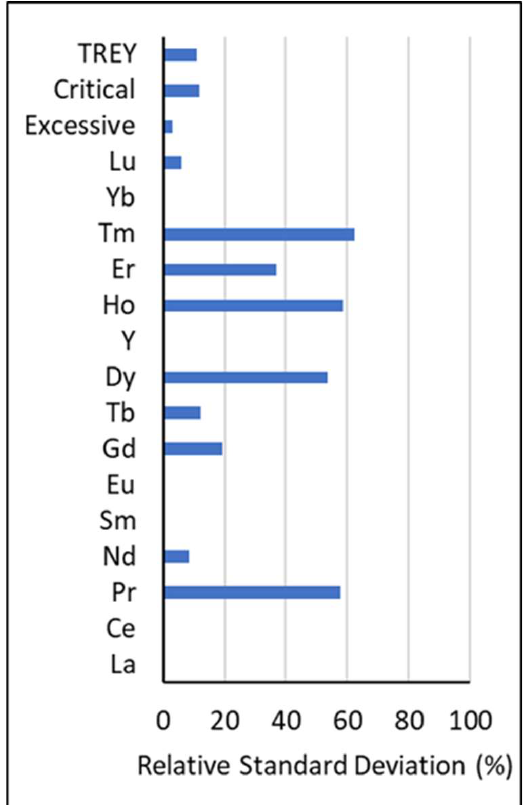
Figure 2. Relative standard deviation (RSD) results.